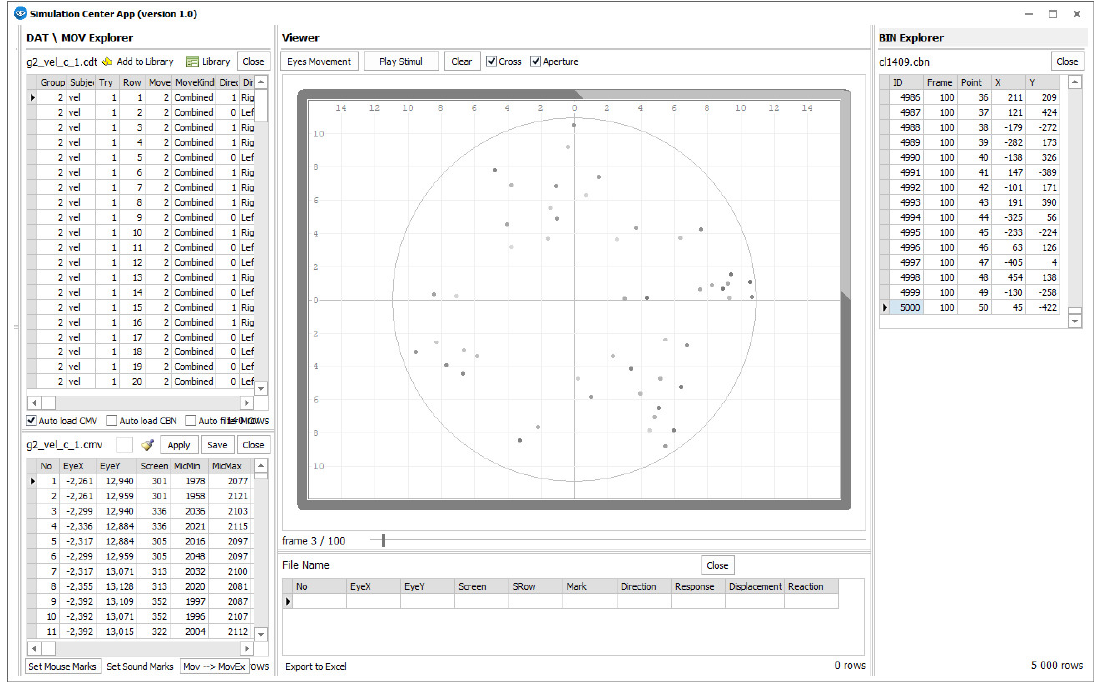
Figure 8. Working session with the main unit of the SimulationCenter application.